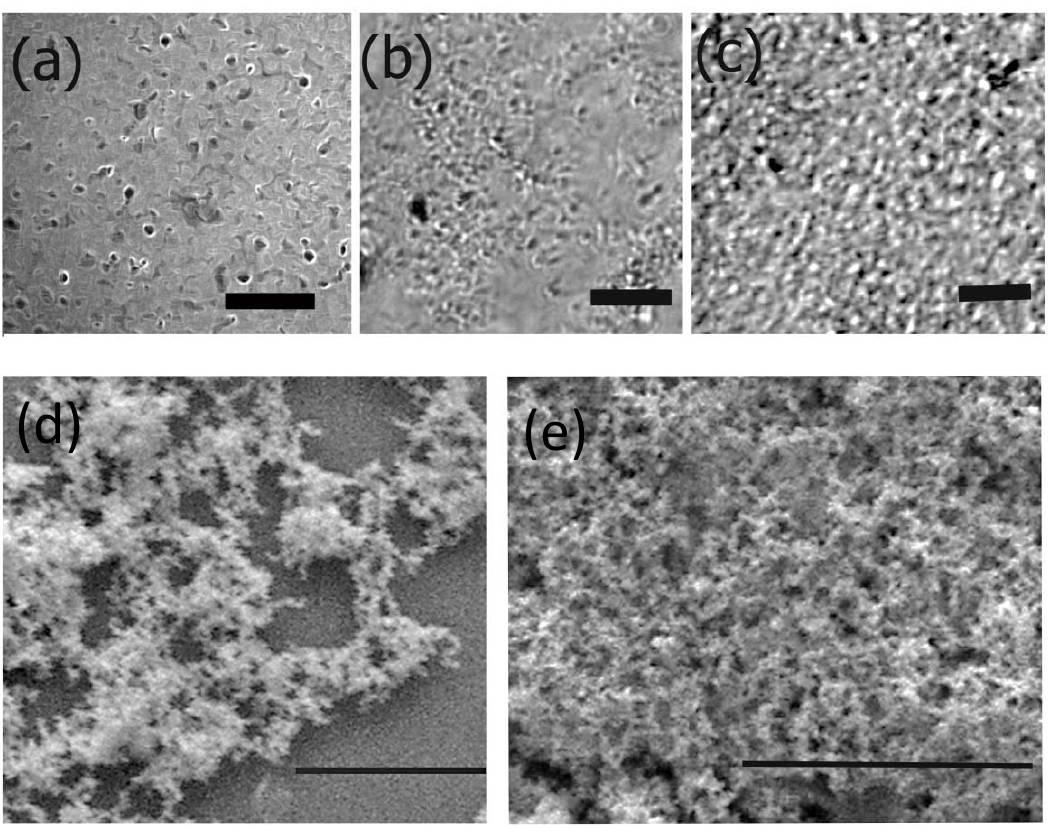
Figure 7. Phase contrast optical microscopy images of cells in the absence and presence of constructs ( a ) Control cells after 24 h (scale bar = 50 μ m); ( b ) Cells seeded with Construct I after 96 h (scale bar = 50 μ m); ( c ) Cells seeded with Construct II after 48 h (scale bar = 50 μ m); ( d ) Scanning Electron Microscopy (SEM) image of cells seeded with Construct I (scale bar = 50 μ m); ( e ) SEM image of cells seeded with Construct II (scale bar =100 μ